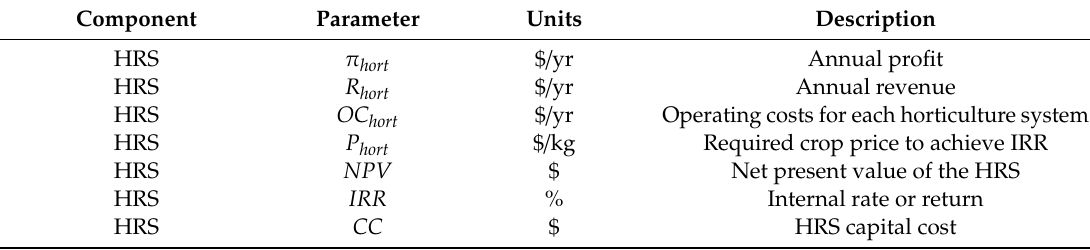
Table A5. Economic model variables not included in the hydrologic